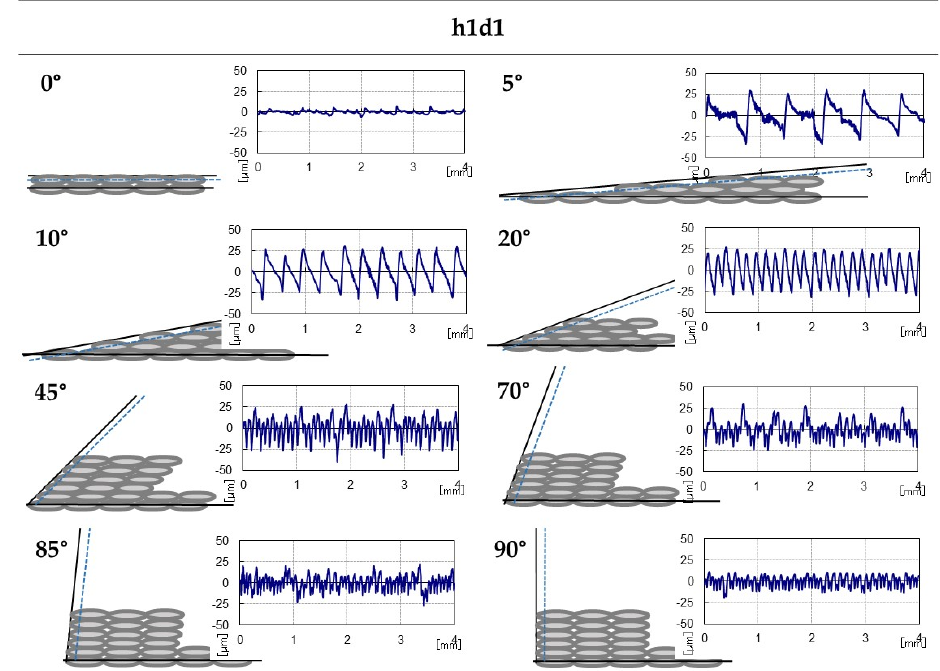
Figure 9. Theoretical (gray) and real (blue) profiles of the h1d1ABS specimen.